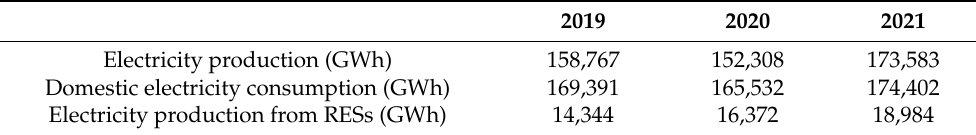
Table 3. Electricity production and consumption in